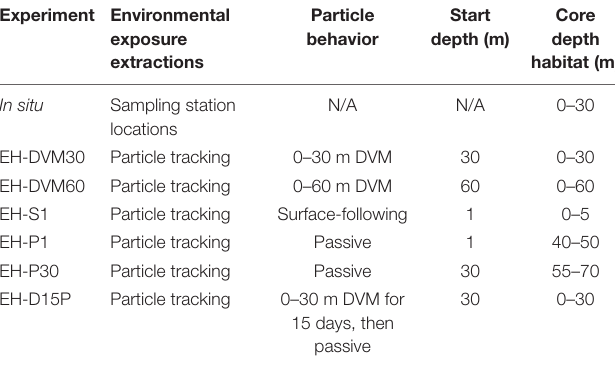
TABLE 2 | Environmental condition extractions for in situ (row 1) and particle tracking (rows 2–7) experiments, including (when relevant) where